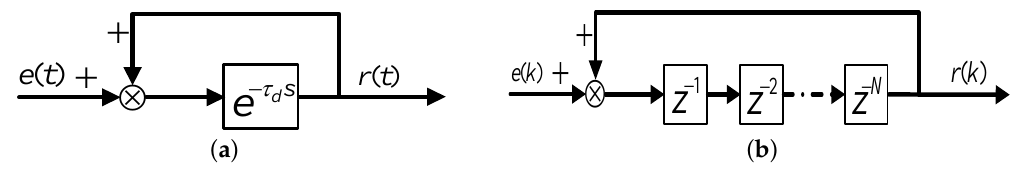
Figure 5. Block diagram of disturbance internal model: ( a ) continuous domain; ( b ) discrete